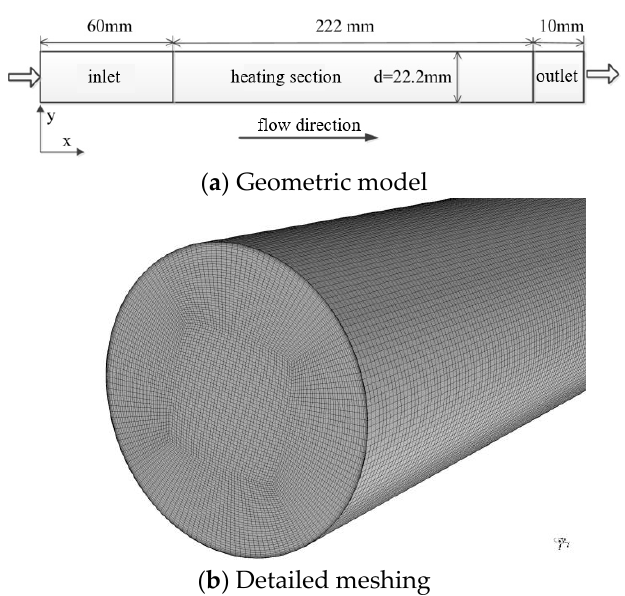
Figure 4. Horizontal smooth circular tube: ( a ) geometric model and ( b ) detailed meshing.